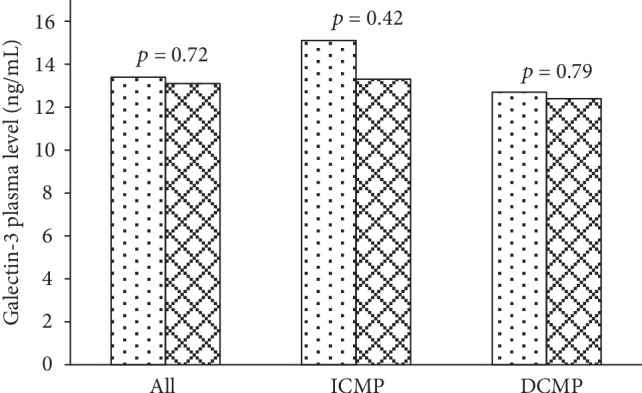
Comparison of plasma galectin-3 baseline (spotted bars) and follow-up (checkered bars) values found no differences when compared in the entire patient cohort and separately in patients with ICMP and DCMP.